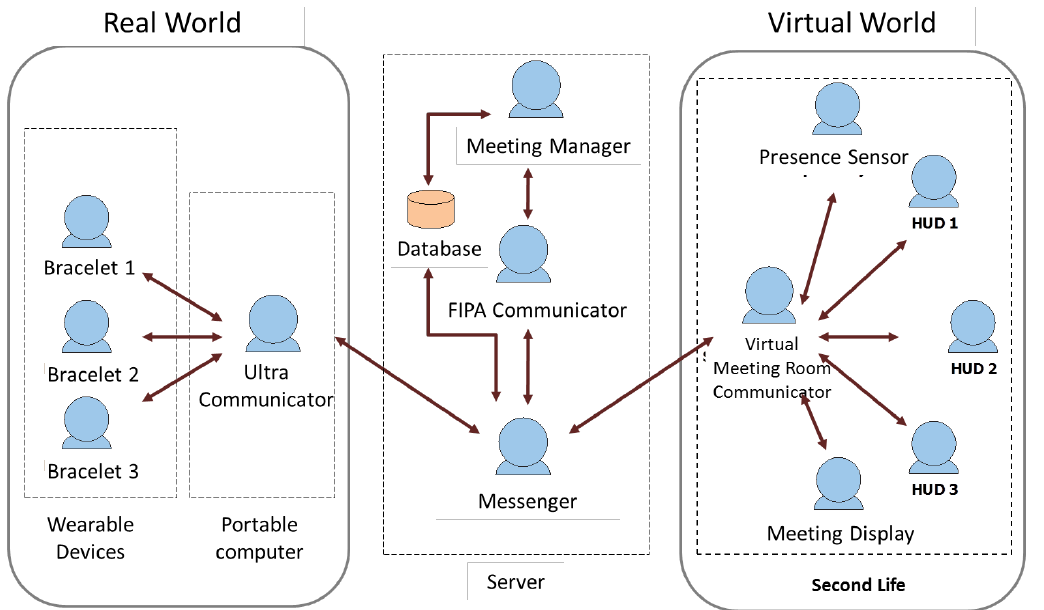
Figure 6. xGroupware agents architecture.